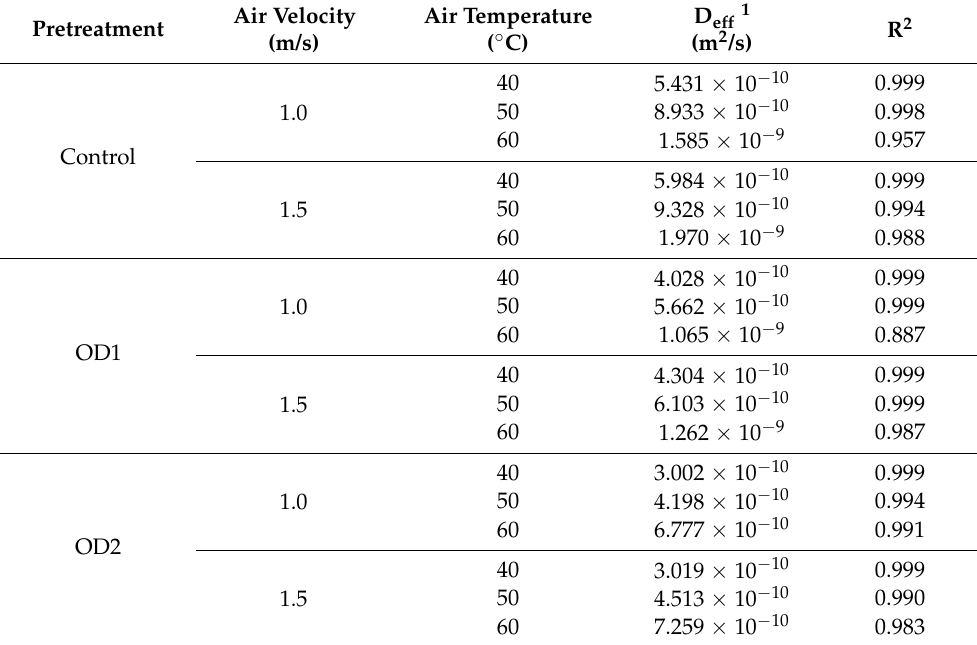
Table 7. The effective moisture diffusivity coefficients during hot air drying calculated by Fick ´ s model.